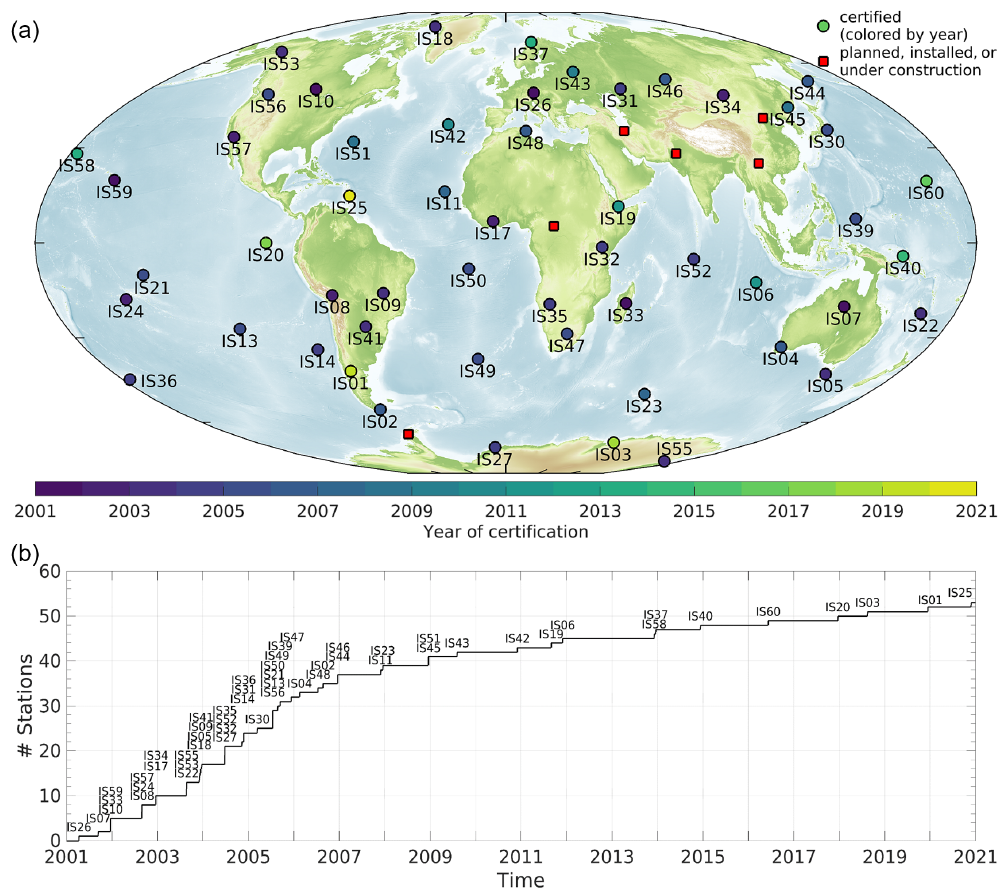
Figure 1. (a) Map of the IMS infrasound network with certified and planned stations (as of January 2021). This study covers the period from 2003 to 2020, during which the number of stations in operation was subsequently increased, as depicted by the approximate certification timeline (b) . All certified stations are considered in this study, although the detection lists and products of IS25 (yellow circle) are not too expressive because of the short period during which the array was certified (end of 2020). The location of 1 of the 60 stations has not been determined yet. The map is based on the ETOPO1 Global Relief Model (NOAA National Geophysical Data Center, 2009; see also Amante and Eakins,